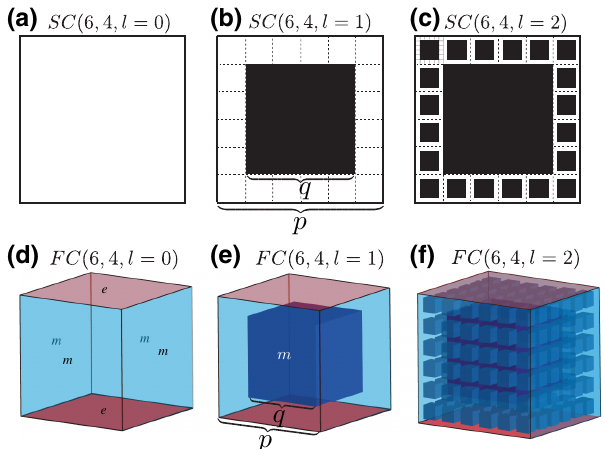
FIG. 21. (a)–(c) The iterative construction of a family of Sier- pi´nski carpets SC ( p , q ) , shown via an illustration of SC ( 6, 4 ) and Hausdorff dimension D H = 1.672. (d)–(f) The iterative con- struction of a family of 3D fractal surface codes defined on a fractal-cube geometry FC ( p , q ) and with m -holes inside, shown via an illustration of FC ( 6, 4 ) and Hausdorff dimension D H = 2.804.